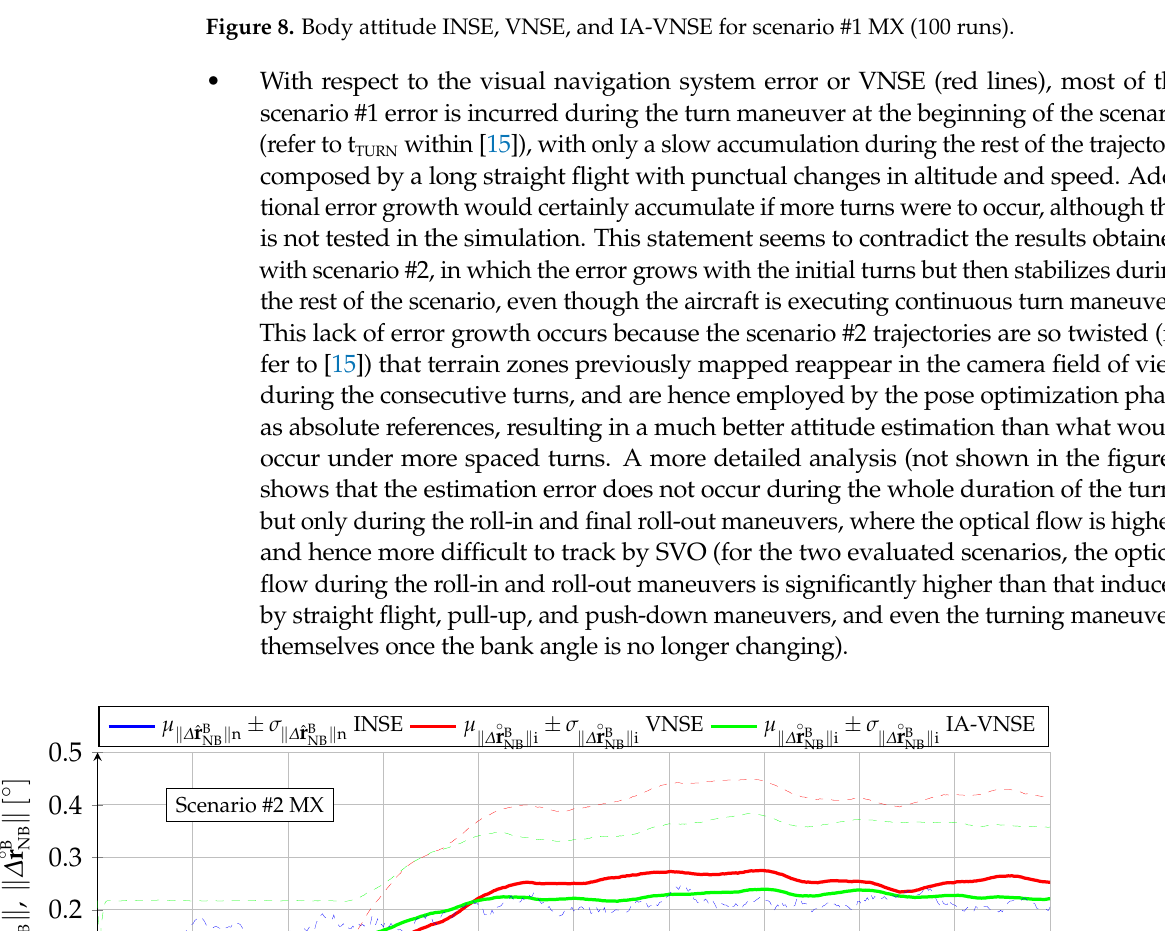
Figure 8. Body attitude INSE, VNSE, and IA-VNSE for scenario #1 MX (100